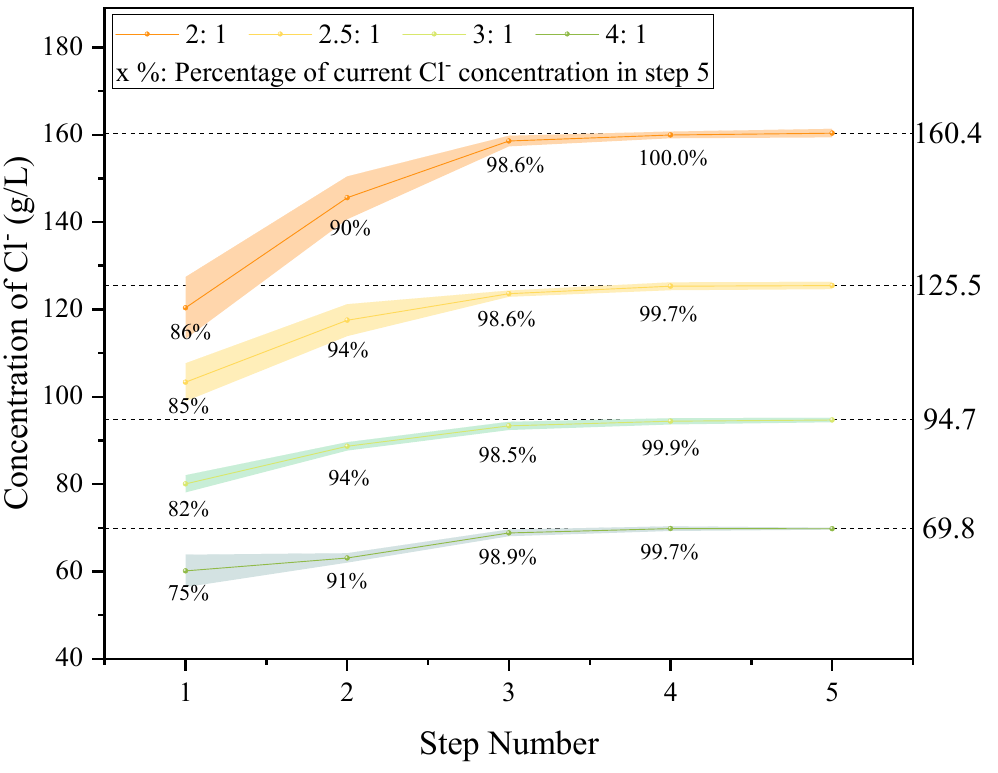
Figure 4. The concentration of Cl − of WWS obtained in different steps. Table 2. Washing experiment